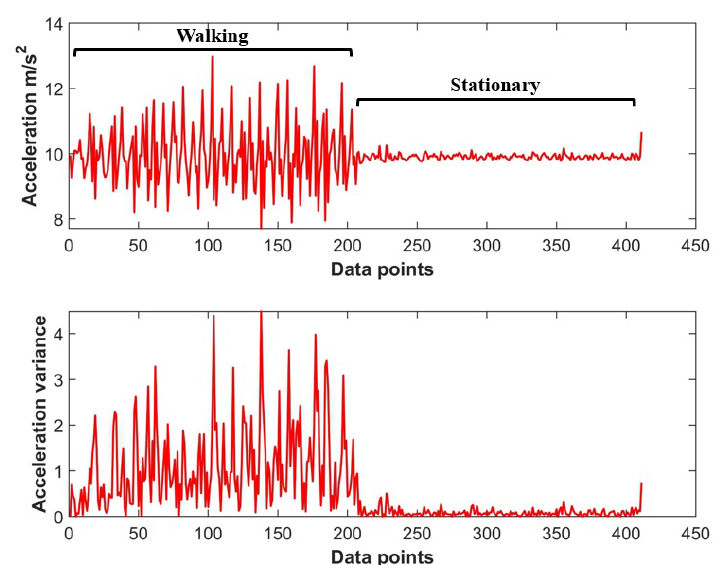
Figure 7. Acceleration data for walking and stationary